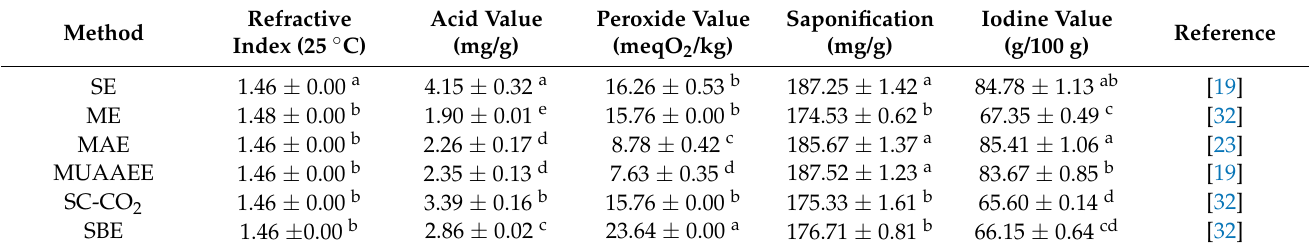
Table 3. Physicochemical characteristics of tiger nut oil under different extraction